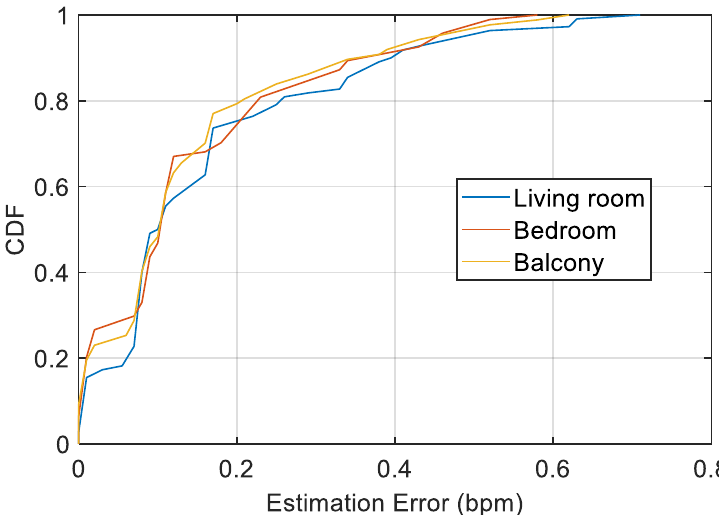
Figure 11. Performance in the living room, bedroom and balcony scenarios.